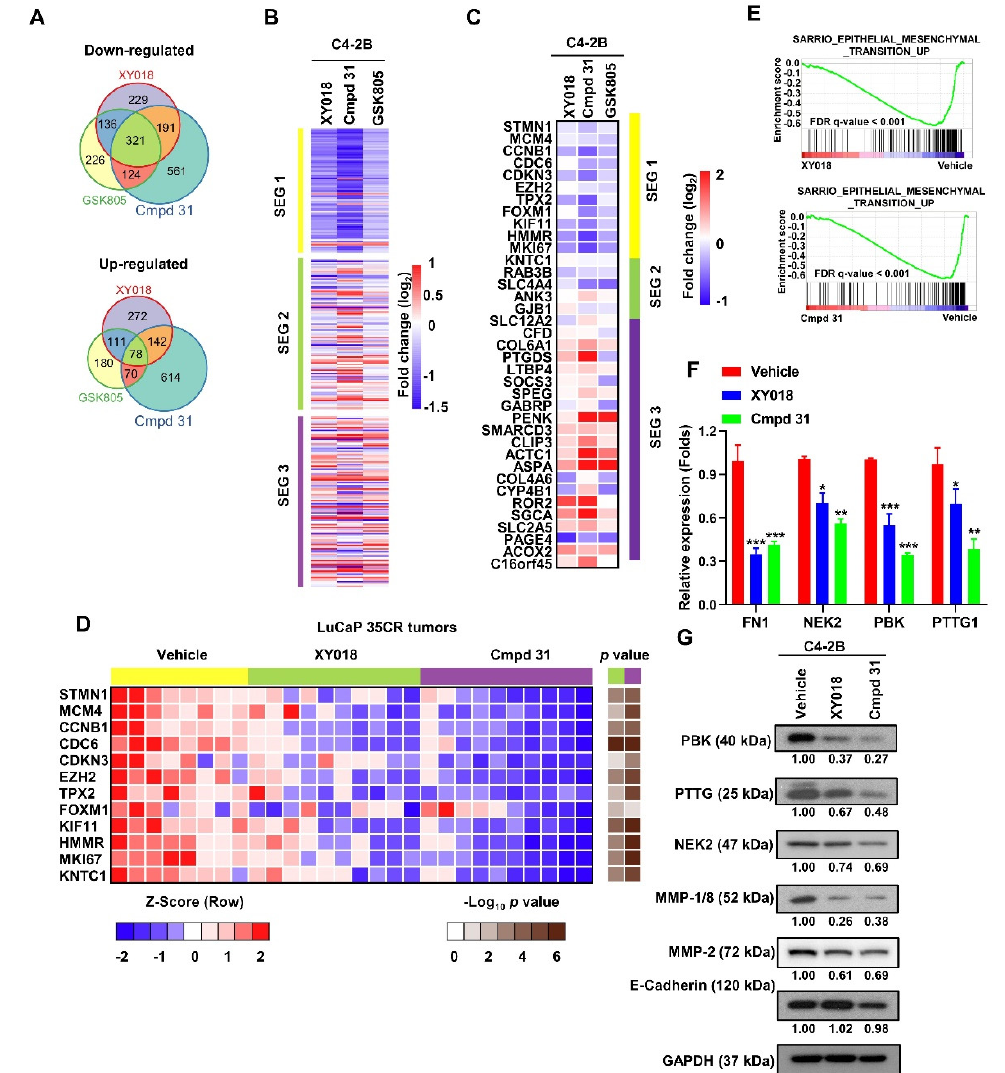
Figure 3. ROR γ antagonists suppress the expression of PCS1 PCa subtype signature genes and